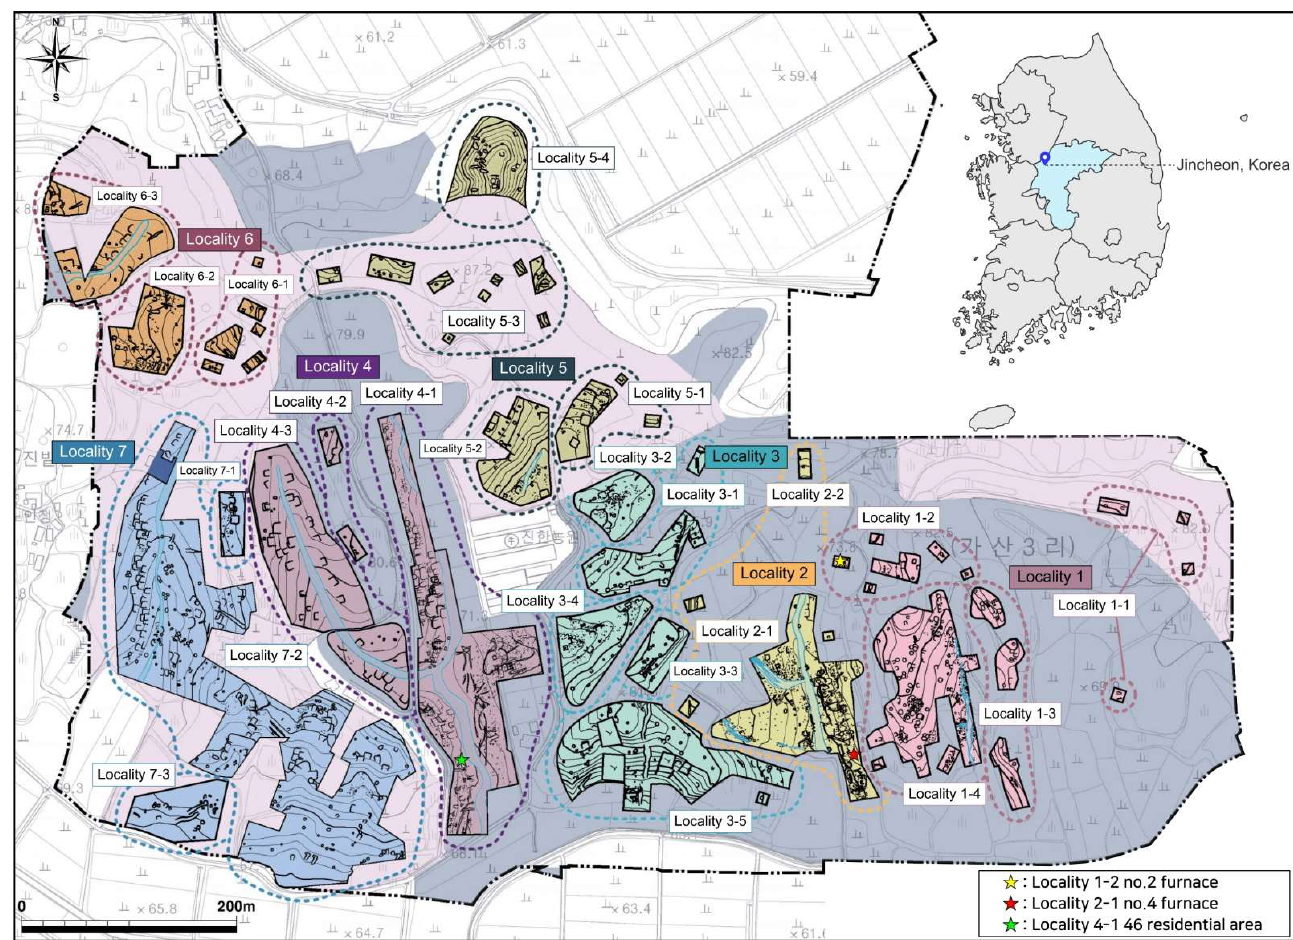
Figure 2. Arrangement of the remains found on the Jincheon Songduri site (Central Institute of Cultural Heritage, 2020). Cultural Heritage,